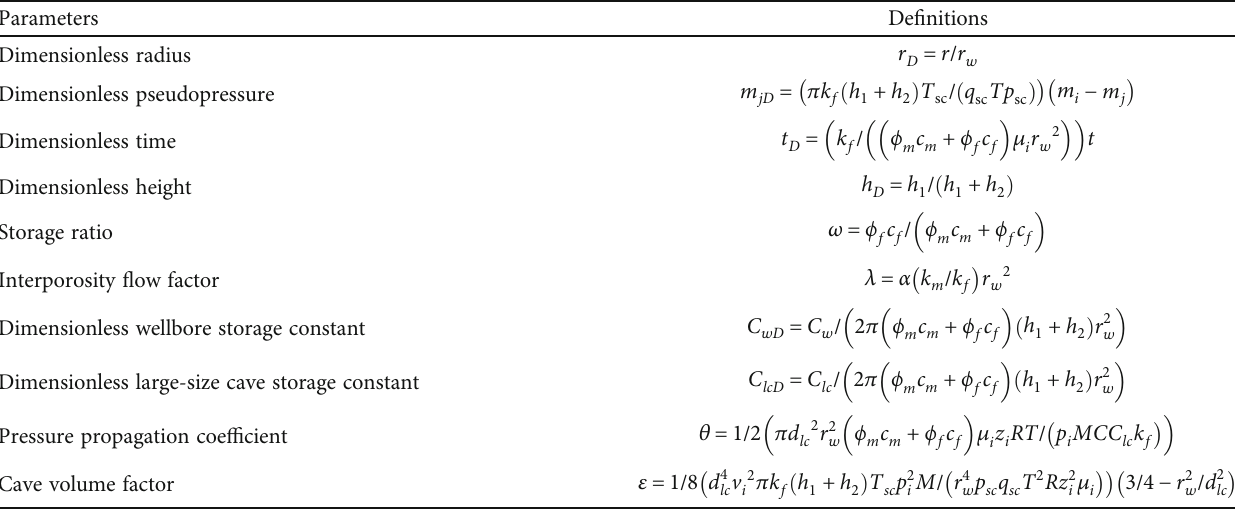
Table 1: Dimensionless